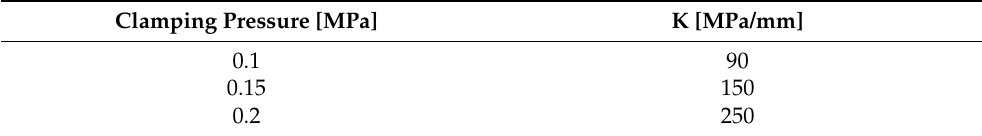
Table 2. Equivalent Winkler elastic support stiffness.